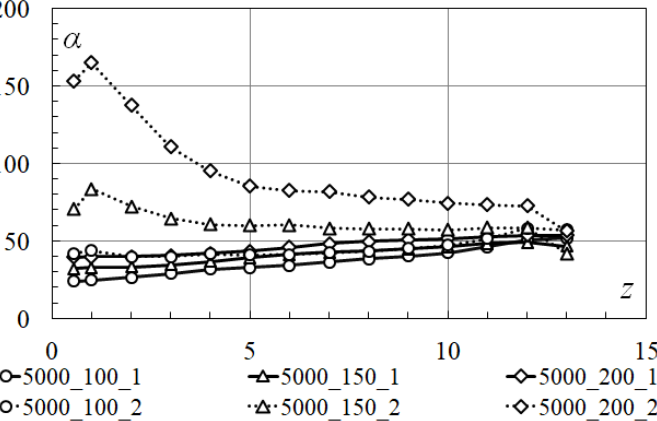
Figure 9. Changing the local heat exchange coefficients α [W/(m 2 ·°C)] along the length of the duct z [m] q 0 = 5000 B т / м 2 , G − Varia